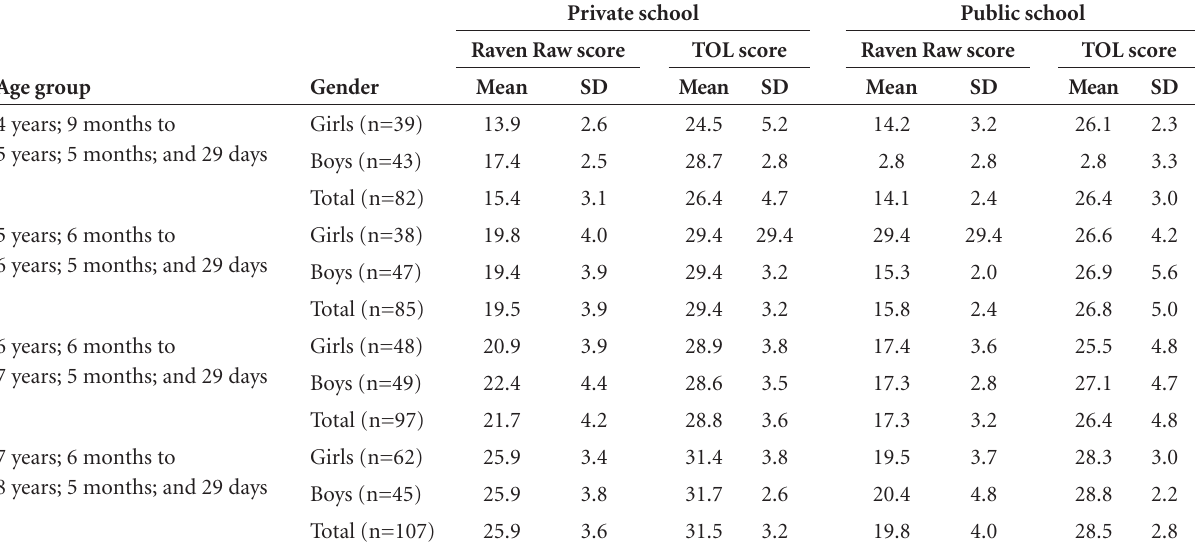
Table 2. Mean scores on the TOL and Raven tests as functions of age, gender, and type of school.